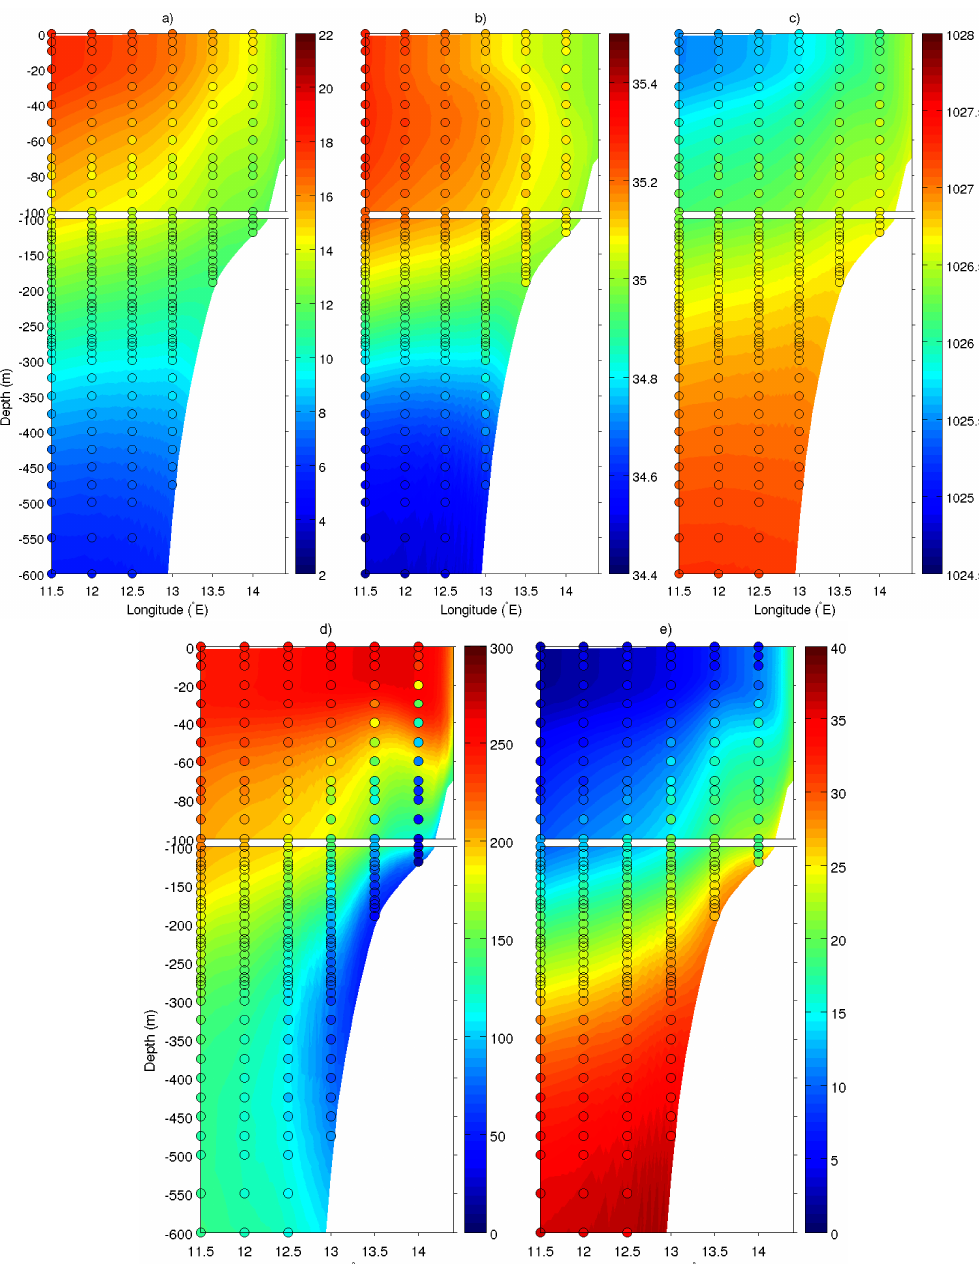
Fig. 5. Simulated 8yr mean of (a) temperature ( ◦ C), (b) salinity, (c) density (kgm − 3 ) , (d) oxygen (mmolO 2 m − 3 ) and, (e) nitrate (mmolNm − 3 ) concentrations at 23 ◦ S between the surface and 600m depth, with a zoom in the first 100m depth. Colored circles for the annual mean CARS databases (2006, 2009) are overlaid on the simulated fields using the same color